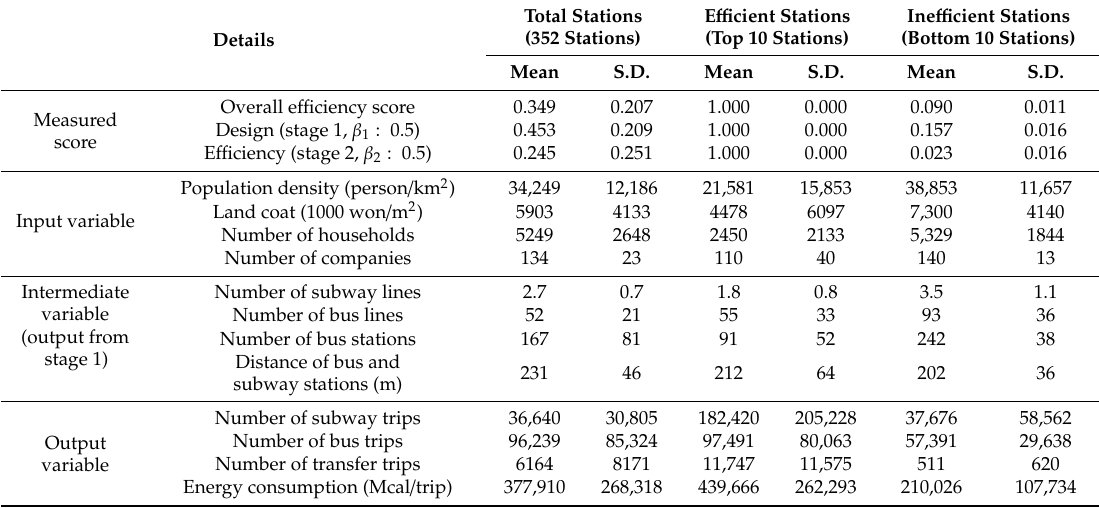
Table 4. E ffi ciency evaluation results for station areas in